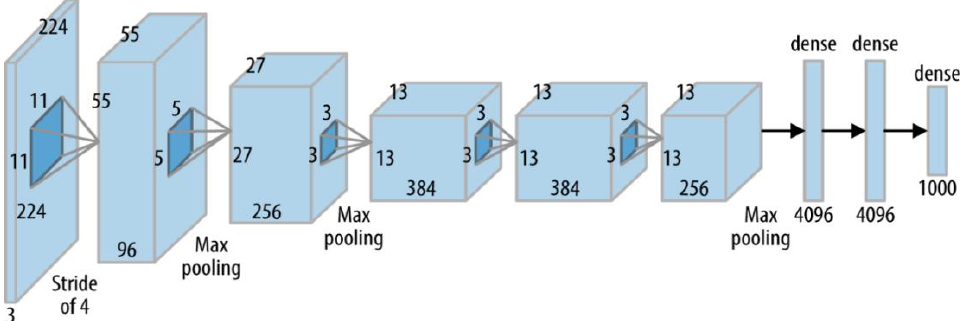
Figure 3. The basic block diagram of AlexNet model.